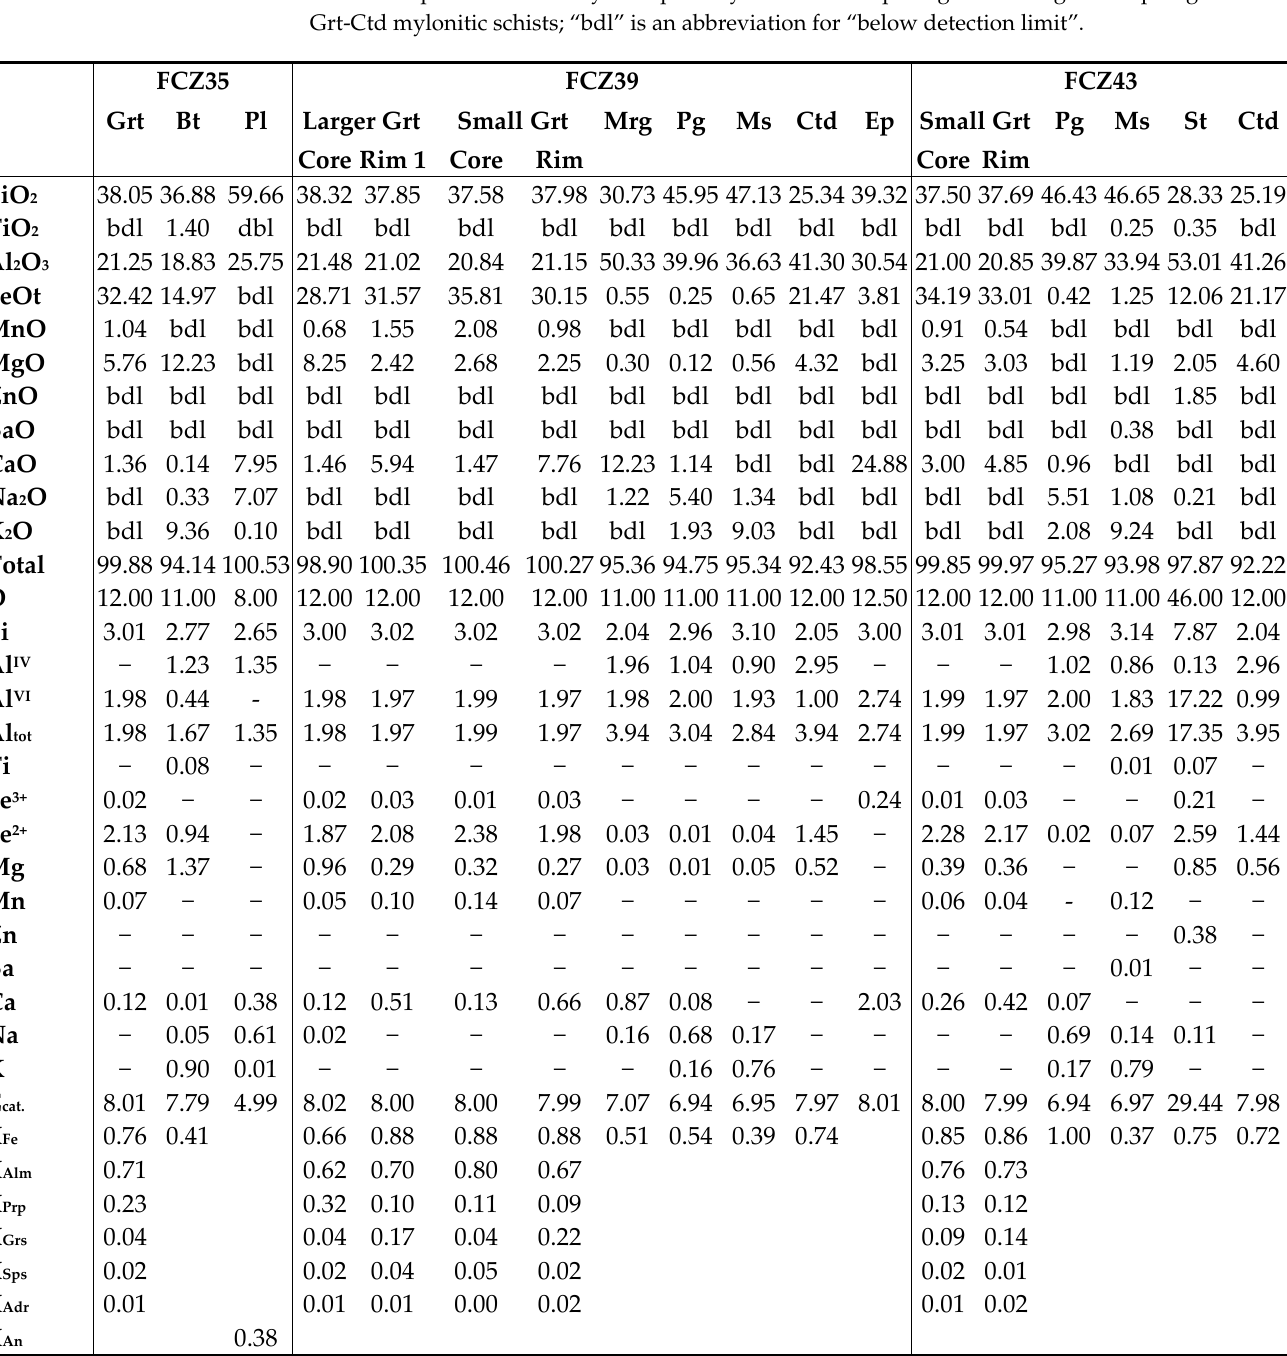
0.38 The Grt-Ctd mylonitic schist (e.g., samples FCZ39, FCZ43) shows a well-defined S m The new mineral assemblage is dominated by muscovite with Si apfu of 3.10–3.14, mylonitic foliation, characterized by aligned white mica-rich layers alternating to quartz- (Table 2), and by paragonite and margarite with Na/(Na + Ca + K + Ba) of 0.70–0.79 and rich ones, both anastomosing lens-shaped garnet aggregates (Figure 4b,c). Moving from 0.15 (Figure 6b), respectively, with X Fe values of paragonite that change markedly from migmatitic Grt-Sil metapelite to Grt-Ctd mylonitic schist, a strong grain size reduction ~0.54 to ~1.00 in most deformed samples (Table 2). It is noteworthy that the occurs (Figure 4a–c), accompanied by a nearly complete substitution of the mineral as- semblage in the mylonites (Table 1). The mylonitic mineral assemblage consists of parago- nite, muscovite, chlorite, chloritoid, garnet, ilmenite and kyanite (Figures 4f–m); either margarite and epidote or staurolite (Figure 4i,j) can be present, depending on the bulk composition of the protolith. Toward the tectonic contact with the granulite-pyriclasite unit, very few sillimanite and garnet relicts can be locally observed (Figure 4f–h), thereby